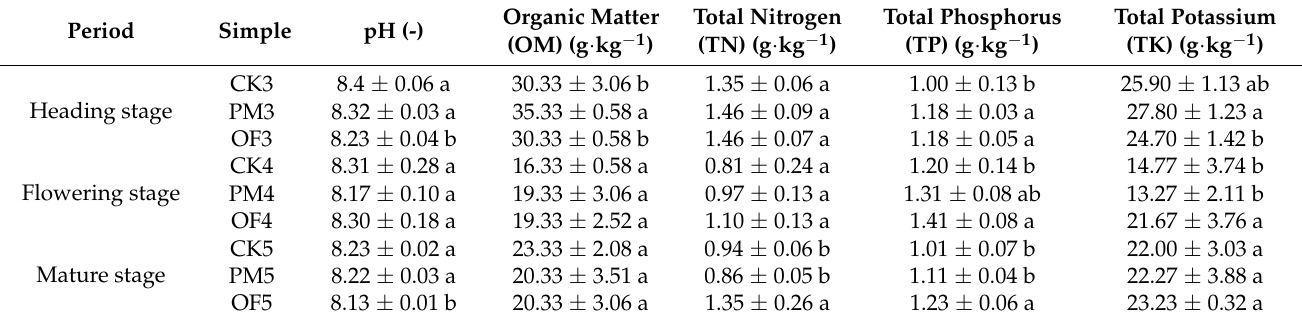
Table 2. Effects of fertilization on soil pH and nutrients in paddy